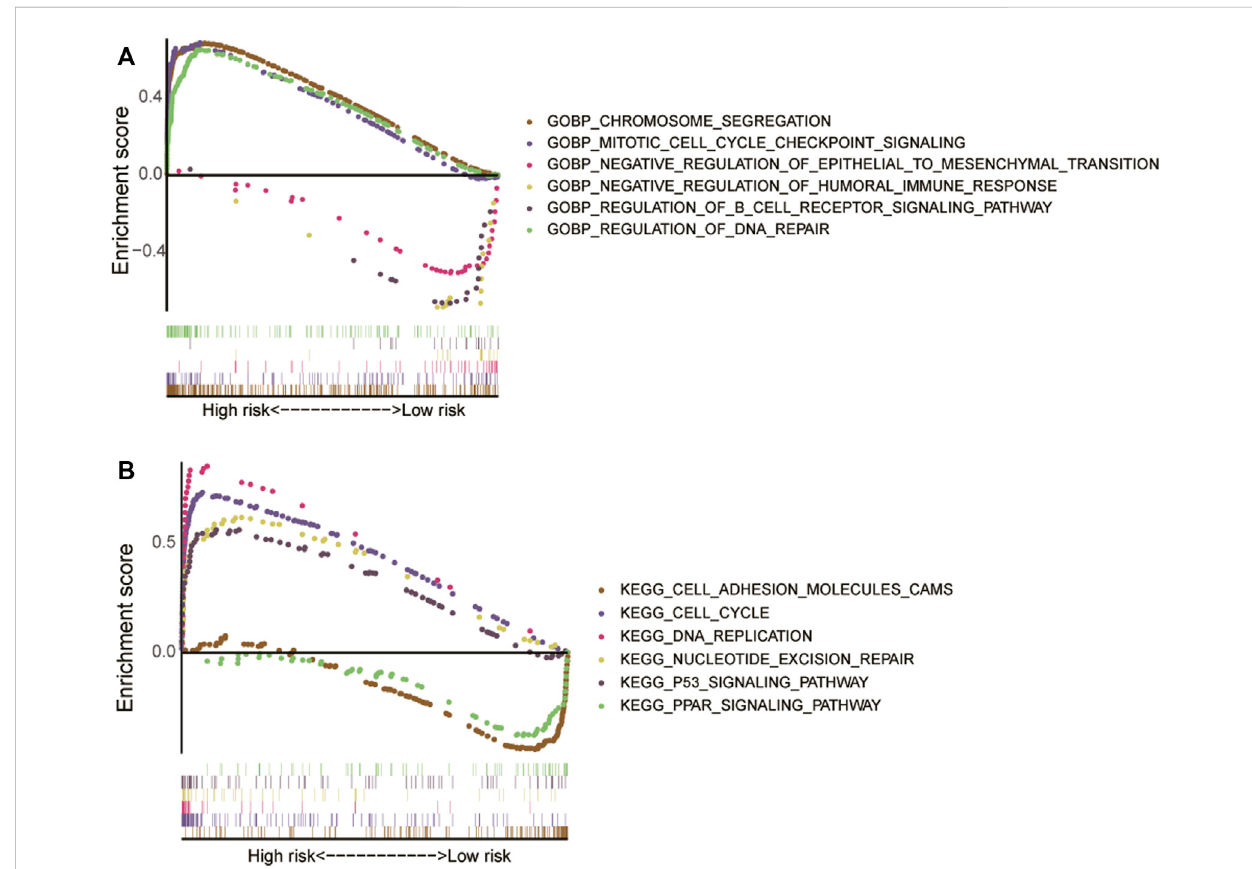
FIGURE 7 TheresultsofGeneSetEnrichmentAnalysisforhigh-andlow-riskgroups. (A) GeneOntologyenrichmentanalysis. (B) KyotoEncyclopediaofGenes and Genomes pathway